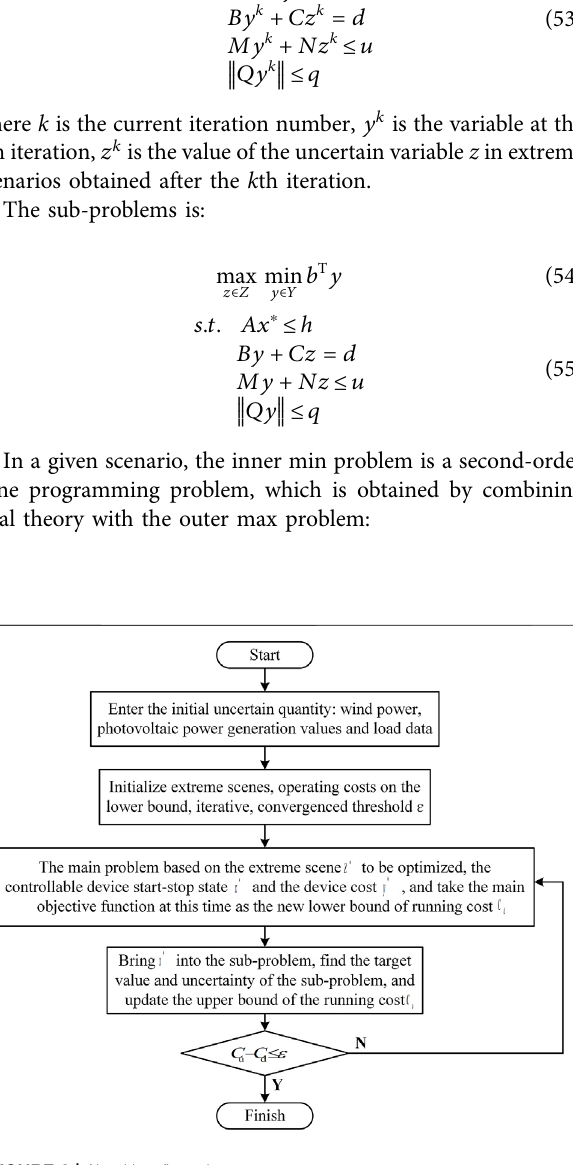
FIGURE 2 | Algorithm fl ow